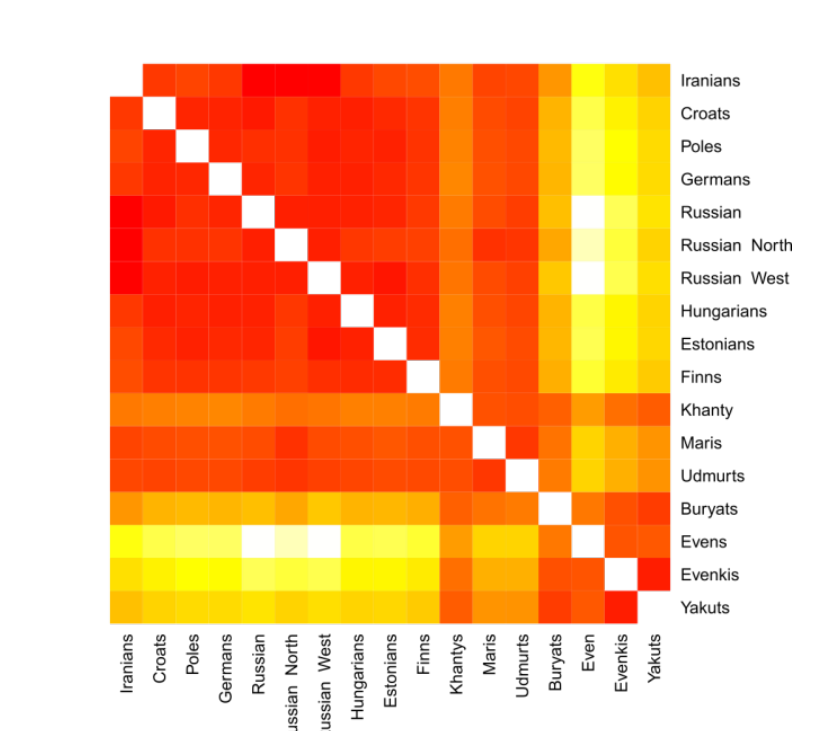
Figure 4. Pairwise genetic distances between Eurasian populations. Darker colors indicate that populations are genetically closer, whereas lighter colors indicate that populations are genetically distant.